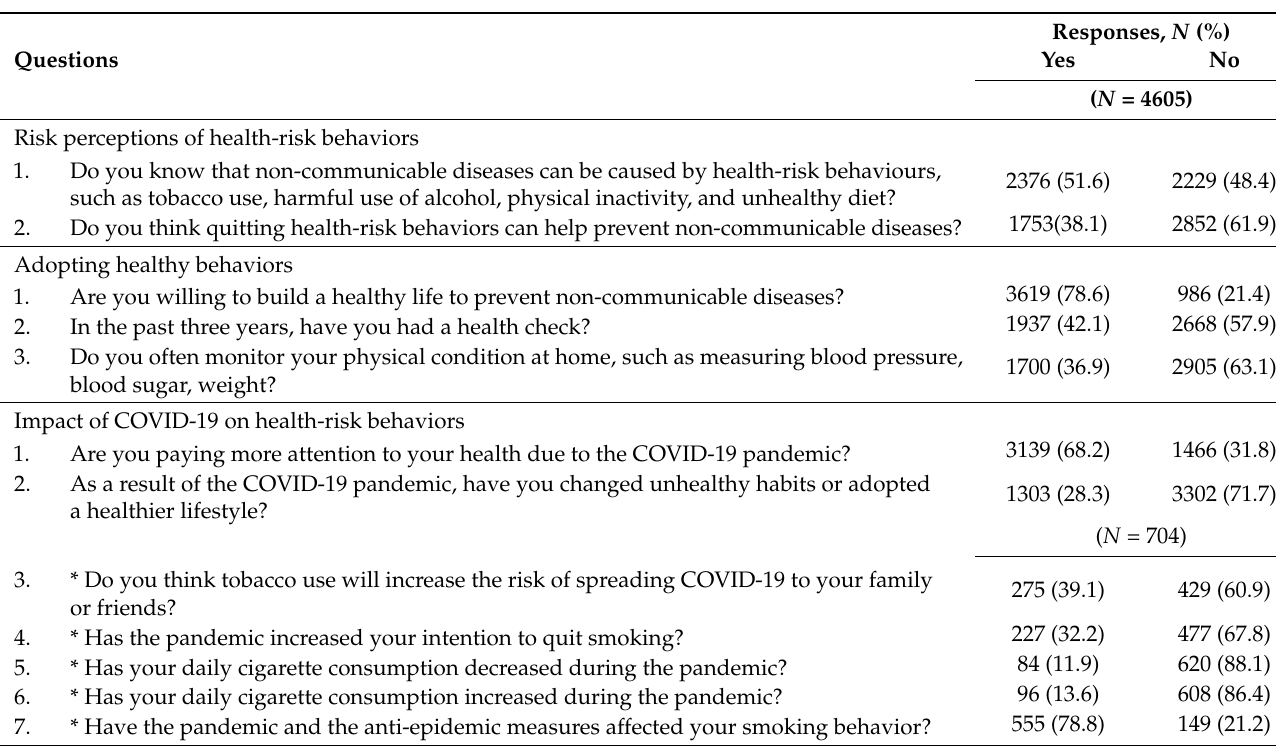
Table 3. Participants’ risk perceptions of health-risk behaviors, adopting healthy behaviors, and impact of COVID-19 on health-risk